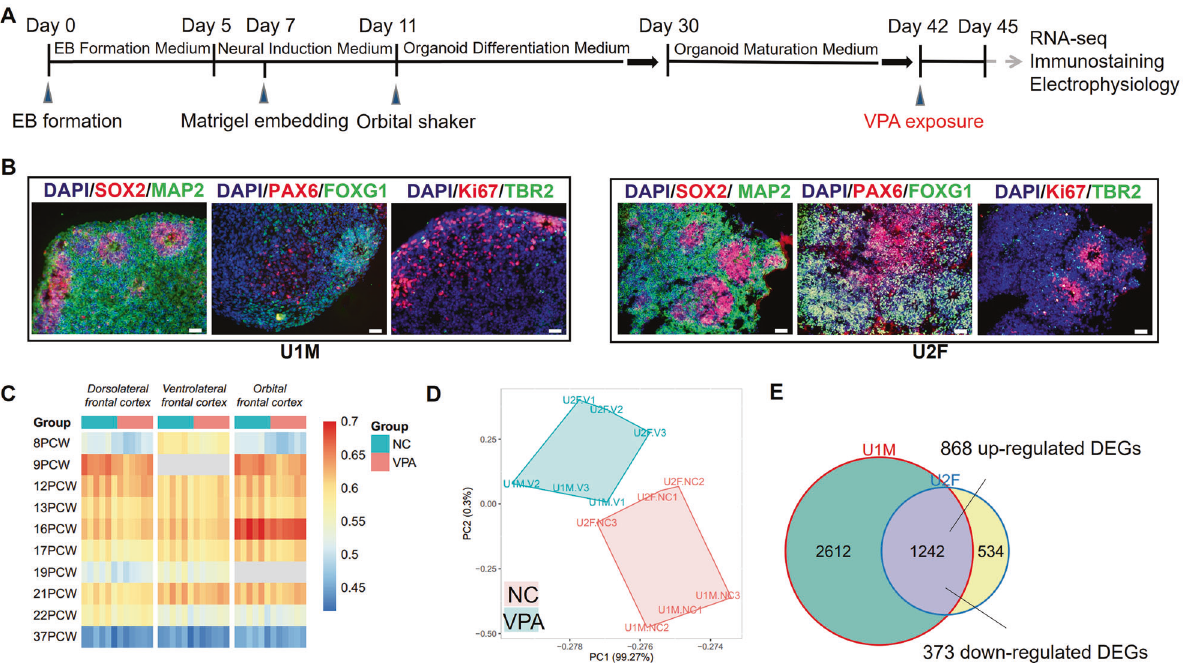
Fig. 1 Identi fi cation of genes affected by VPA exposure in hFOs. A Work fl ow of this study. B Immuno fl uorescence characterization for hFOs. Ventricular zone marker, SOX2 and ki67; intermediate zone marker, TBR2; cortical plate markers, MAP2; forebrain-speci fi c markers, FOXG1 and PAX6. Scale bar, 50 μ m. C Transcriptome correlation analysis between hFOs (day 45) and human fetal brains. PCW post-conception weeks. The color bar indicates the correlation coef fi cient. D Principal component analysis for RNA-seq data from VPA-exposed and control hFOs. E Overlap between VPA-induced DEGs identi fi ed in U1M and U2F hFOs. Among the 1242 overlapped genes, the expression change directions of COMT in U1M and U2F were not consistent. The gene COMT was not considered as a VPA-induced DEG, the remaining 1241 shared VPA-induced DEGs between U1M and U2F